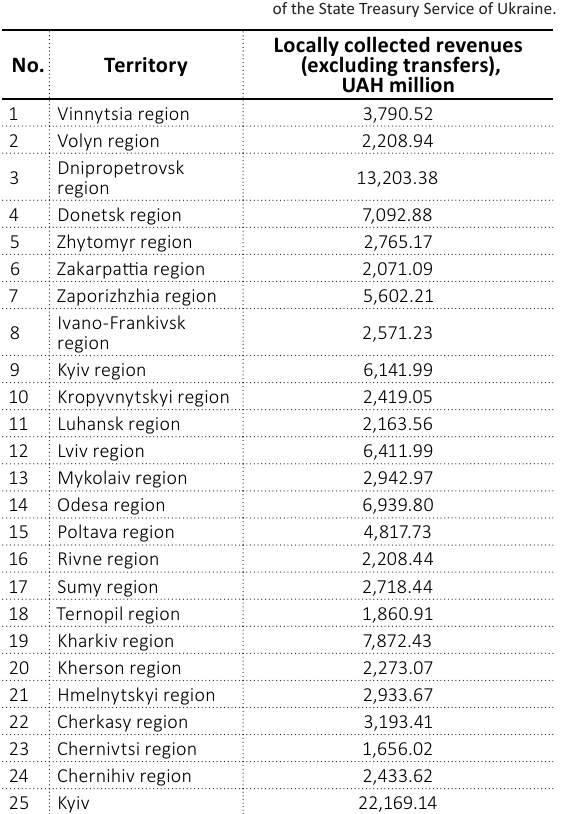
Table 3. Revenues of local budgets in Ukraine in 2015